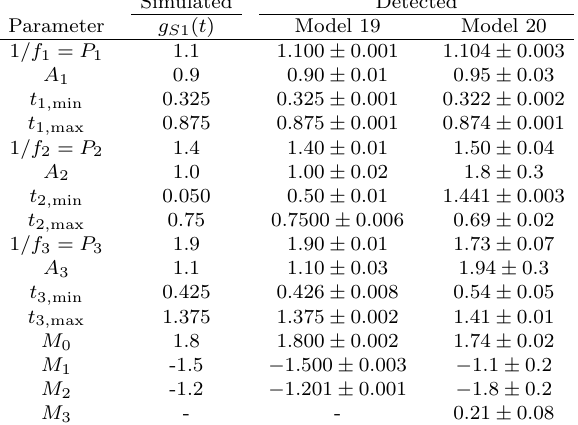
TABLE 3 Simulated data a of Eq. 24. Only first two observations of all n (cid:63) = 500 observations are shown below.